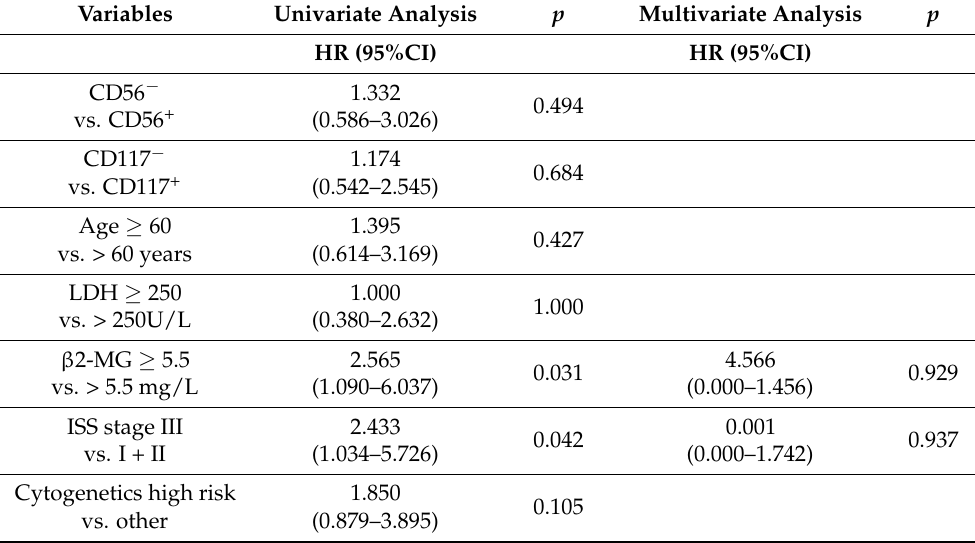
Table 4. Univariate and multivariate COX regression analyses for PFS.